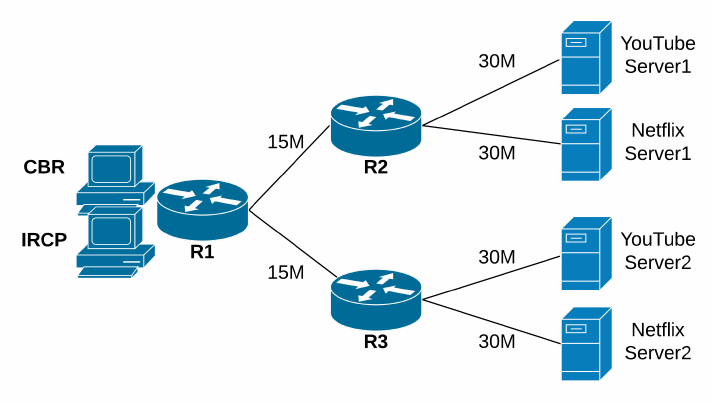
Figure 8. Multipath scenario for fairness